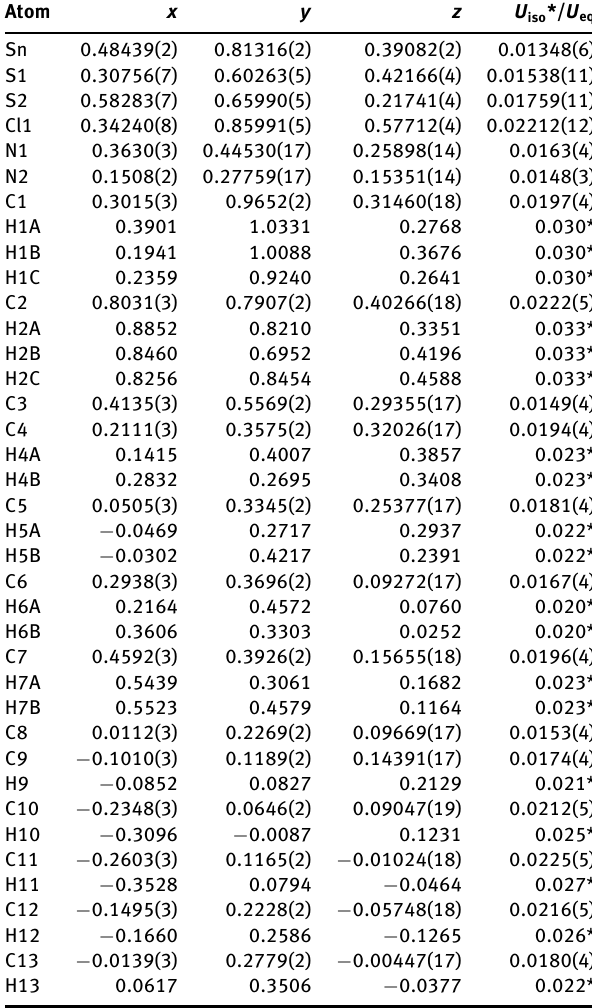
Table 2: Fractional atomic coordinates and isotropic or equivalent isotropic displacement parameters (Å 2